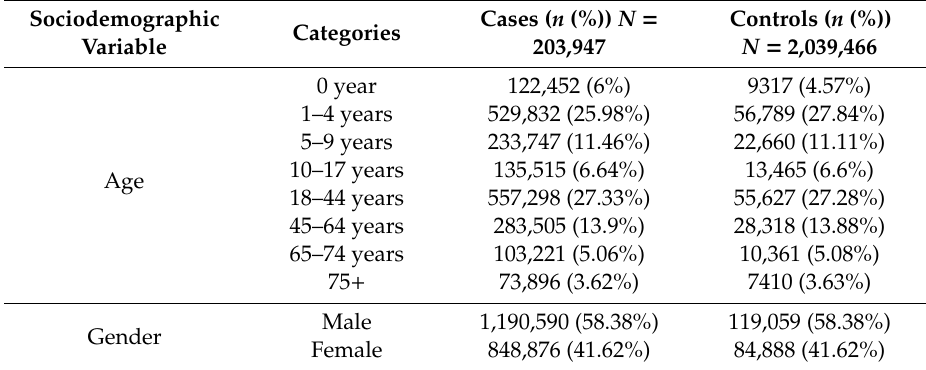
Table 2. Age and sex distribution (matching variables) of cases and controls.